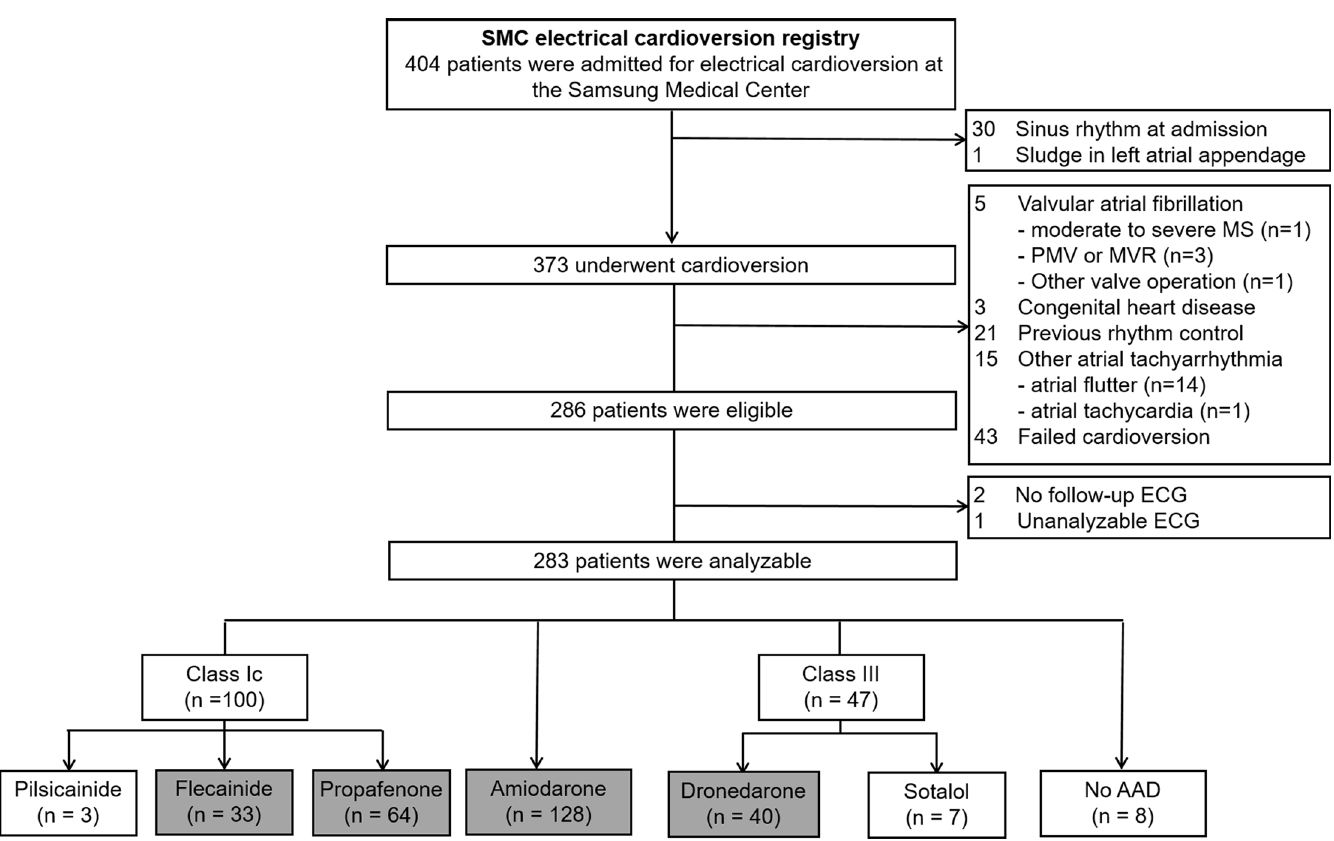
Fig 1. Study population. AAD indicates antiarrhythmic drug; ECG, electrocardiogram; MS, mitral stenosis; MVR, mitral valve replacement; PMV, percutaneous mitral balloon valvuloplasty. AADs in the grey box were included in the final analysis.